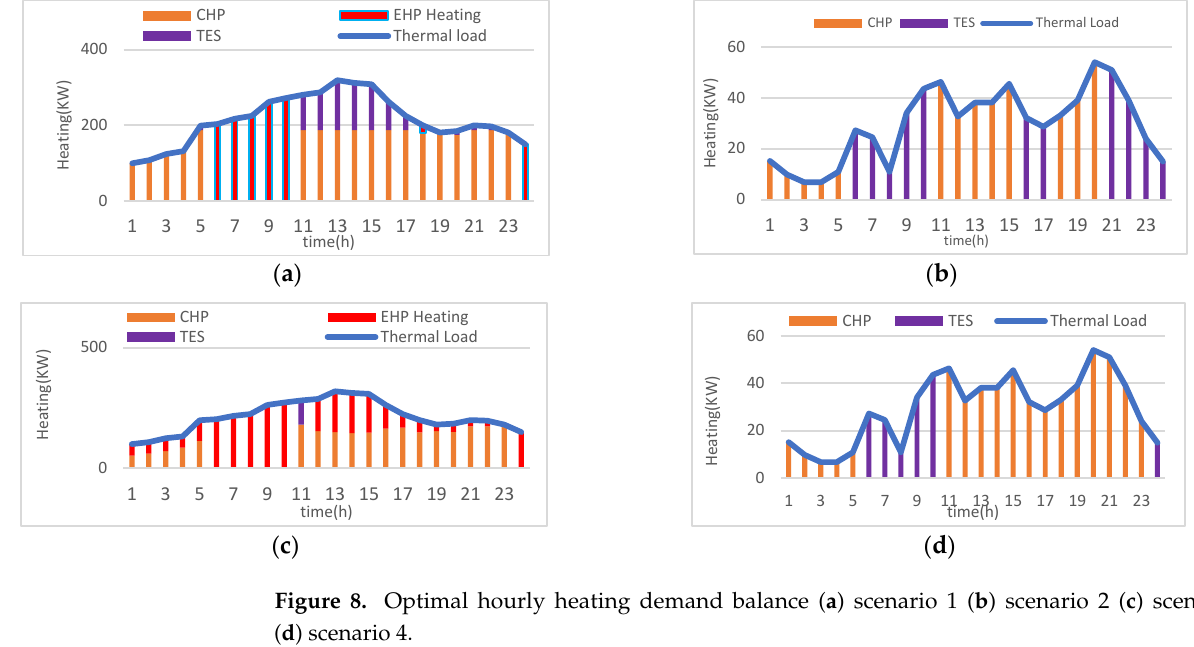
Figure 8. Optimal hourly heating demand balance ( a ) scenario 1 ( b ) scenario 2 ( c ) scenario 3 ( d ) scenario 4.